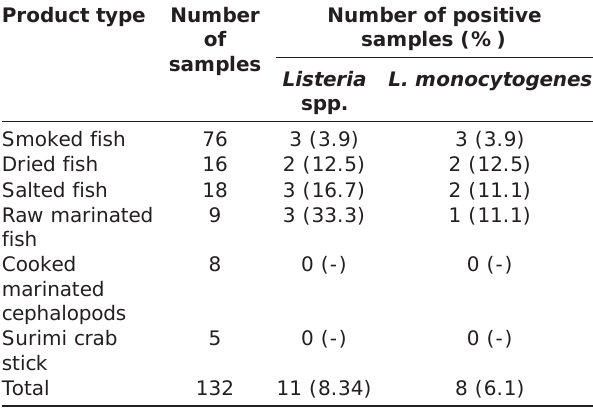
Table-1: Prevalence of Listeria spp. and L. monocytogenes in RTE seafood. Product type Number